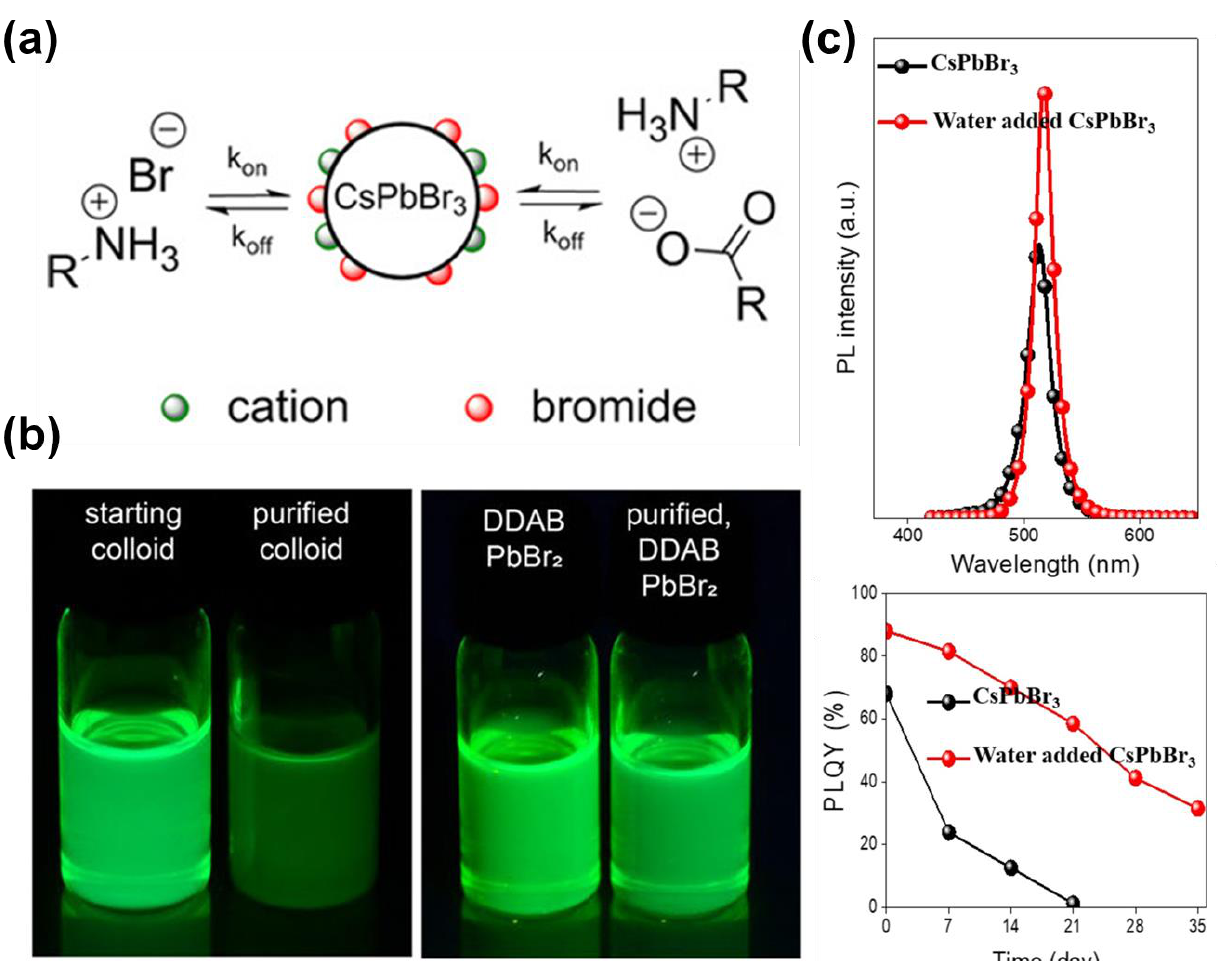
Figure 1. ( a ) Schematic representation of the dynamic surface stabilization by oleylammonium bromide, oleylammonium oleate, and oleylamine. In addition, the relevant acid/base equilibria are depicted [47]. Copyright 2016 American Chemical Society. ( b ) Schematic representation of the recovery of colloidal lead halide perovskite NCs and the variation of measured QYs for the starting colloid and the same colloid subjected to several treatments [12]. Copyright 2018 American Chemical Society. ( c ) The PL spectra ( λ ex = 400 nm) and the stability investigation of CsPbBr 3 NCs and water-added CsPbBr 3 NCs [48]. Copyright 2020 Elsevier. Table 1. Result of perovskite film after ligand exchange. KI inorganic ligand increased the